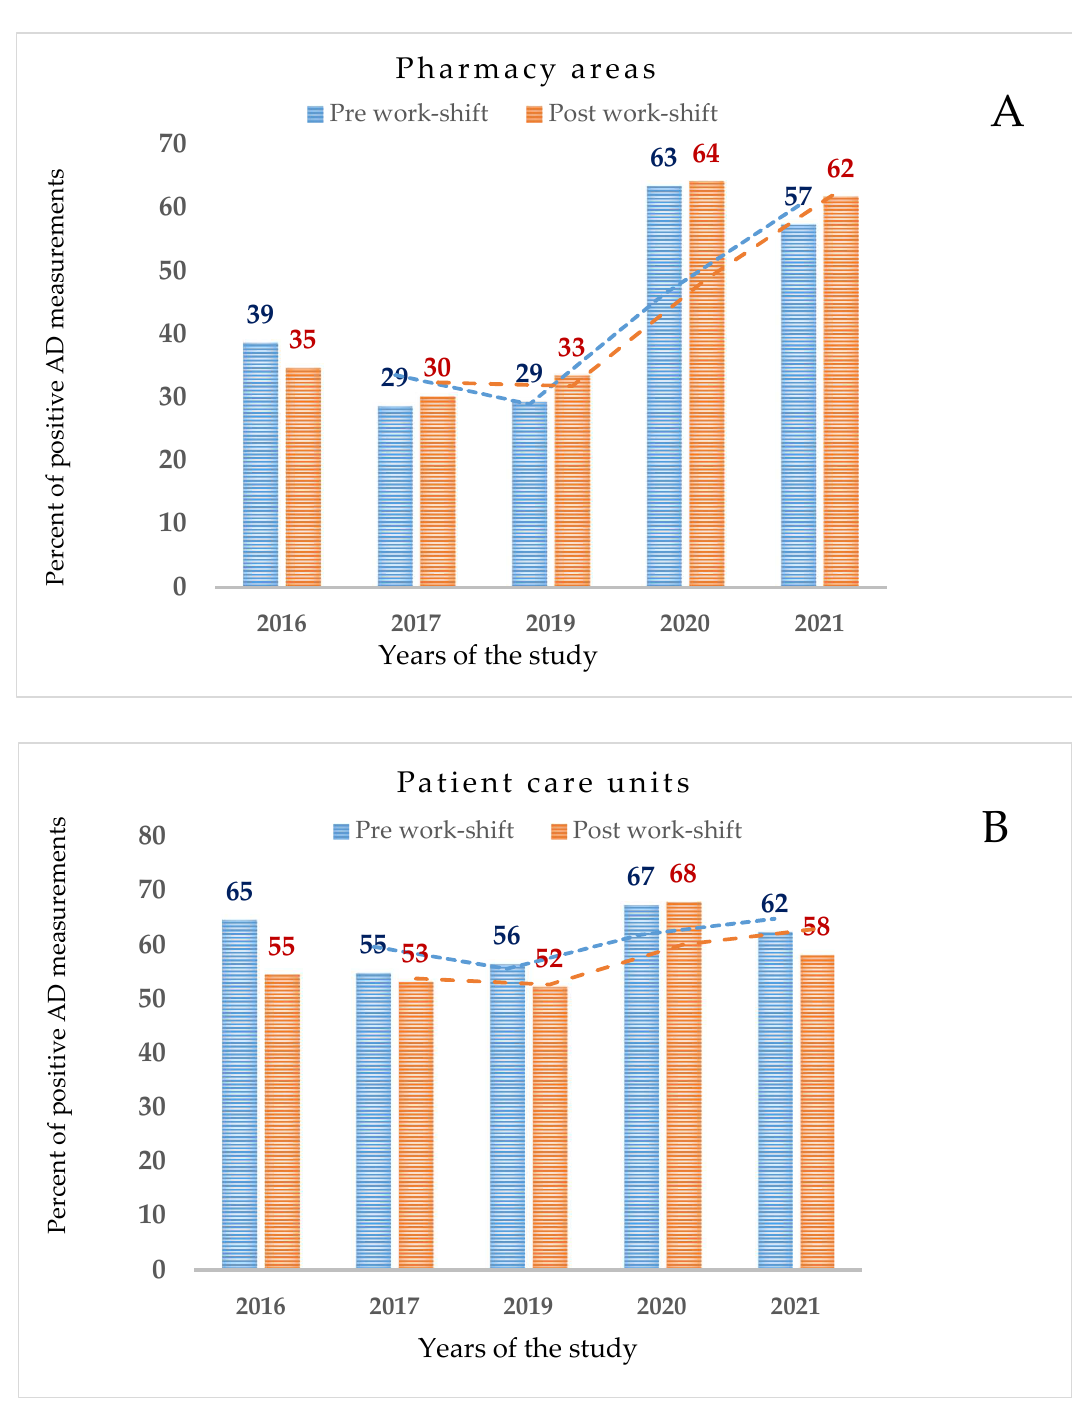
Figure 3. In panel ( A ) (pharmacy areas) and in panel ( B ) (patient care units) percent of positive wipe samples in relation to the pre- and postwork shift over the 5-year survey are